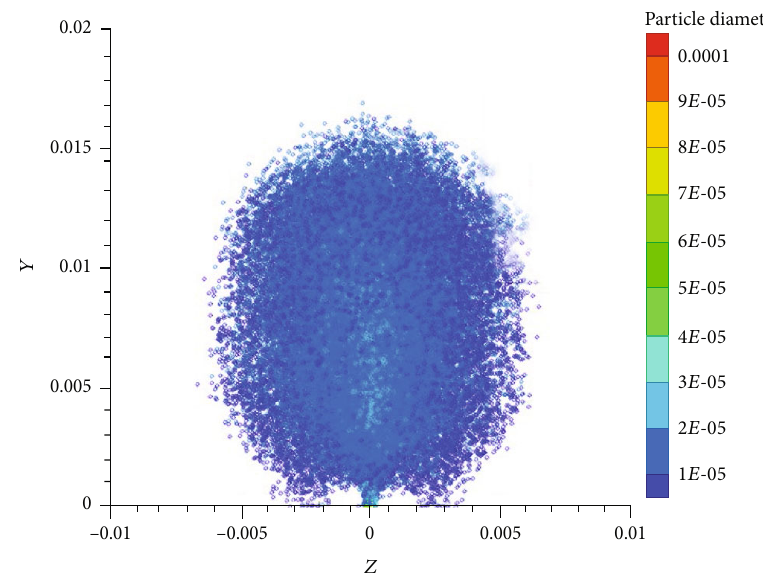
Figure 19: Spray spread at t = 0 : 5 ms with low grid resolution.